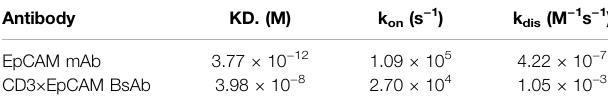
TABLE1| BindingkineticsoftheCD3×EpCAMBsAbandEpCAMmAbusingBLI. Antibody KD.